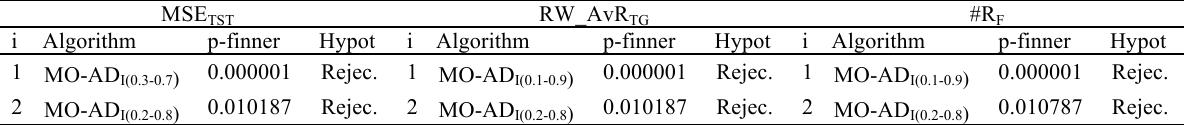
Table A.11 Finner Table with α = 0.05 for the methods on MSE TST , R W _AvR TG and #R F measures on MEDIAN INT/ACC